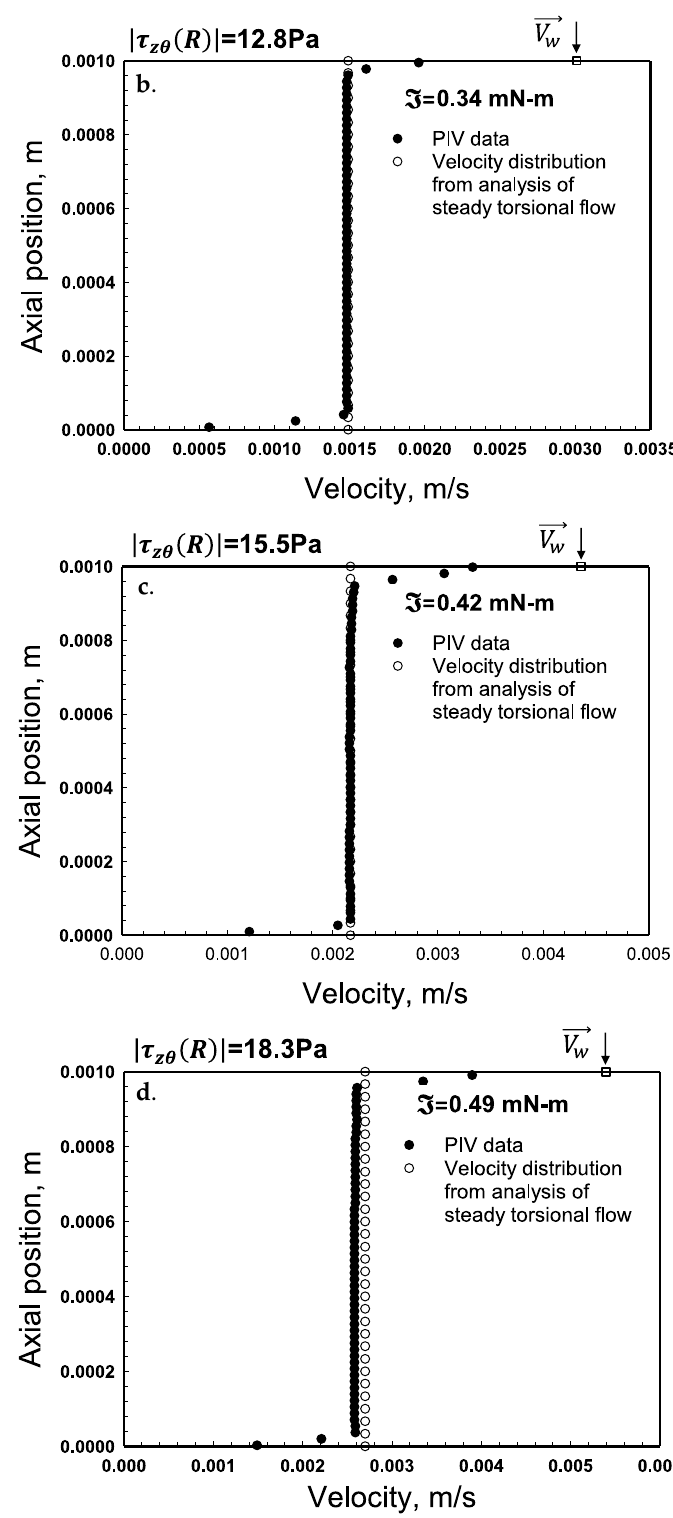
Figure A2. Plug flow with wall slip in steady torsional flow using parallel disks for the gap, H = 1.0 mm for the shear stress at the edge values of ( a ) 10.1 Pa, ( b ) 12.8 Pa, ( c ) 15.5 Pa, ( d ) 18.3 Pa. The PIV data are from Medina-Bañuelos et al., 2021. Filled symbols are from PIV data and unfilled are from calculations.